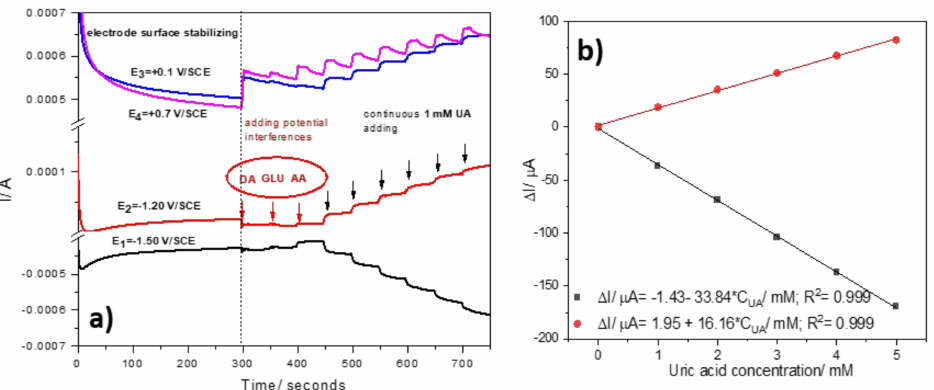
Figure 10. ( a ) Four-pulsed amperograms (MPAs) recorded with the PE_03 paste electrode in 0.1 M NaOH supporting electrolyte in the presence of potential interferences (1 mM) and continuous adding of 1 mM UA; the detection potential levels of: E1 = − 1.50 V/SCE, and E2 = − 1.20 V/SCE. ( b ) Calibration plots recorded at: E1 = − 1.50 V and E2 = − 1.20